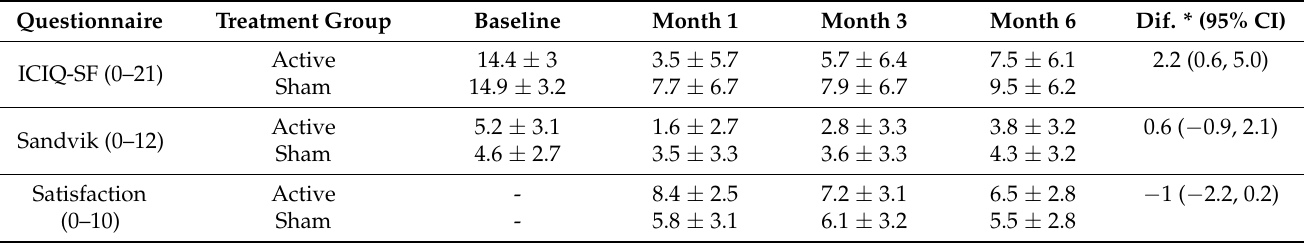
Table 3. Mean ± SD values obtained by self-assessed questionnaires performed during the study.